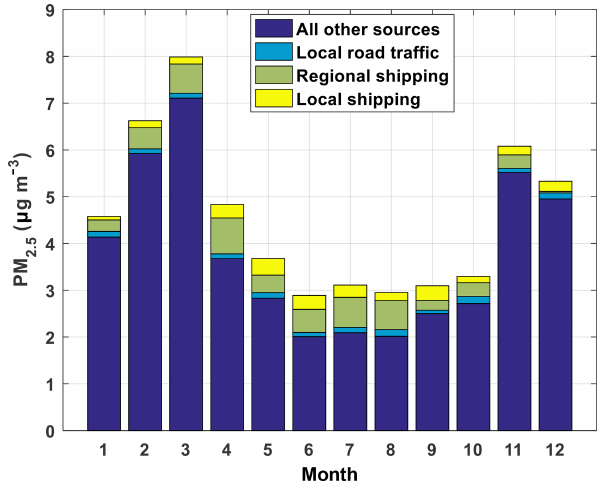
Figure 11. Modelled monthly mean contributions from local ship- ping, regional shipping and other sources (including contribution from the boundary condition) to PM 2 . 5 concentrations at Eriksberg for the year 2012.